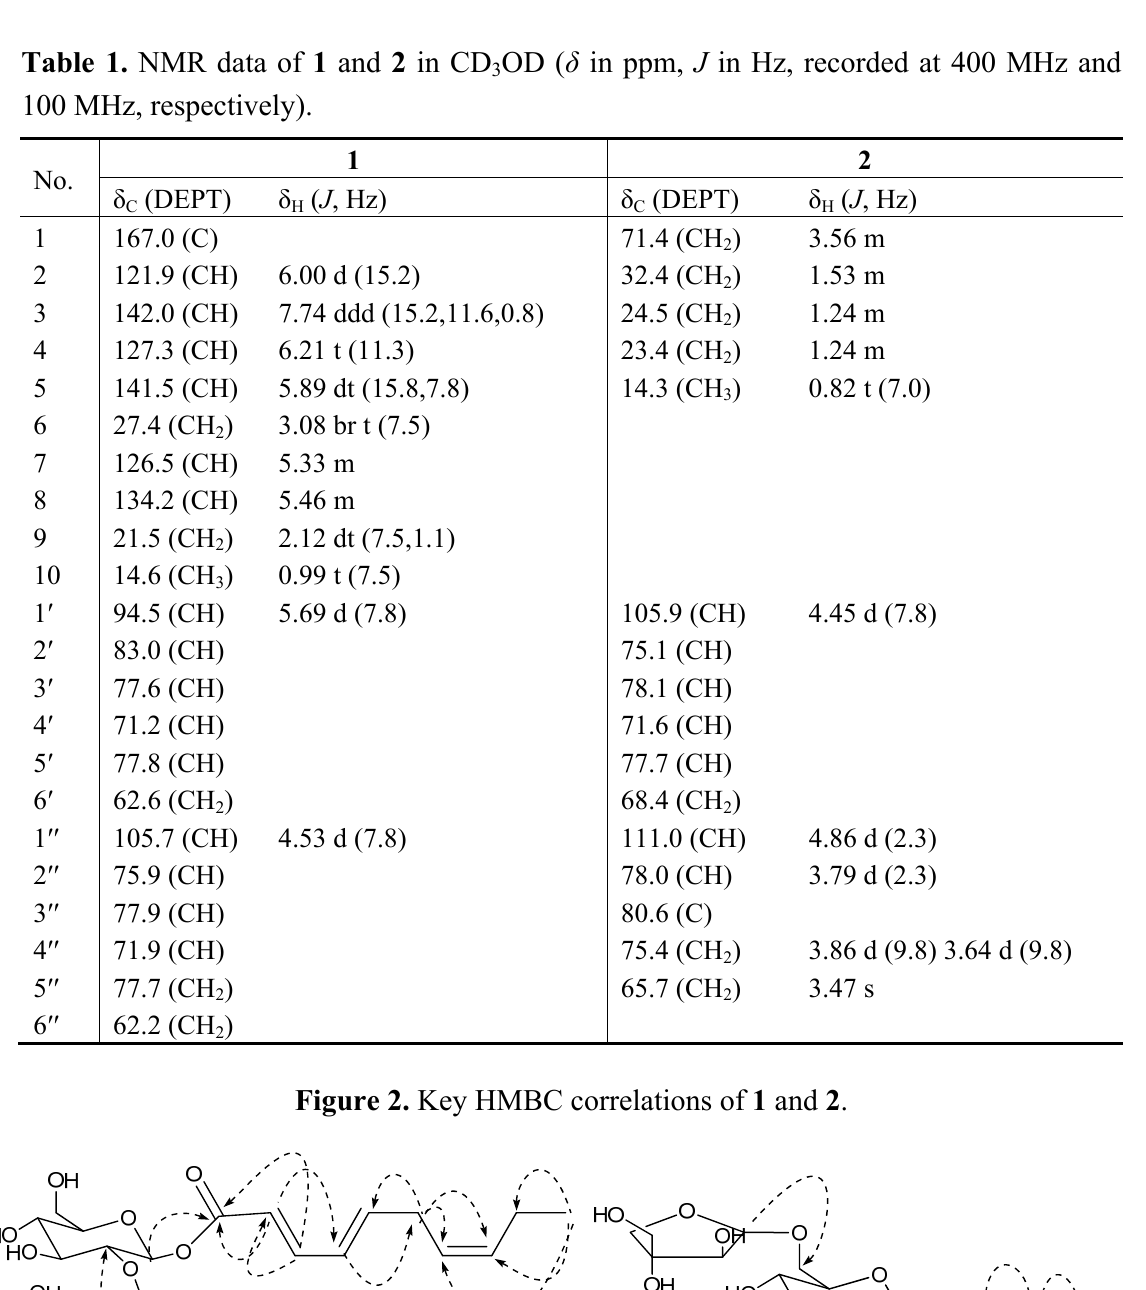
OD ( δ in ppm, J in Hz, recorded at 400 MHz and 3